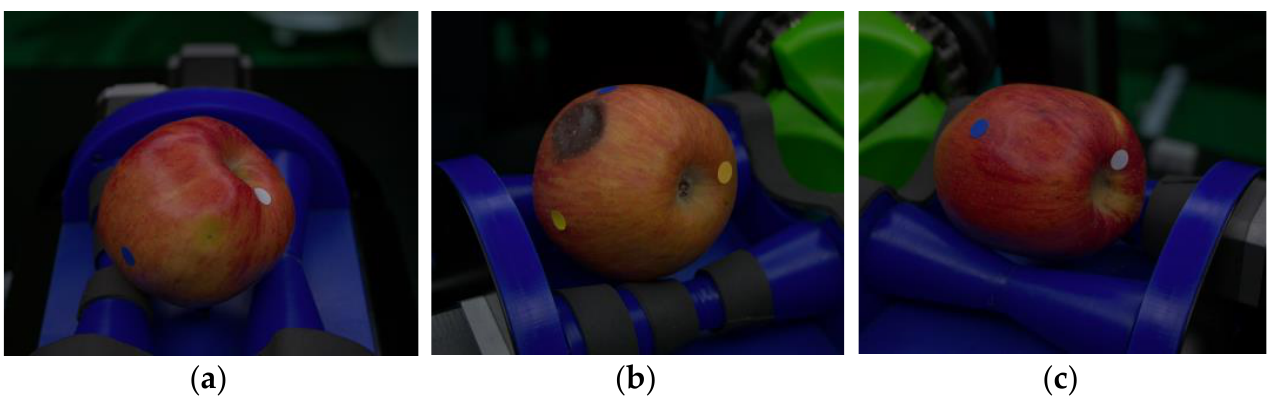
Figure 4. Example of sampled apples for surface exposure calculation: ( a ) Normal; ( b , c ) Surface-defects apple. Table 2. Quantitative surface exposure rate for each type of apple. Type